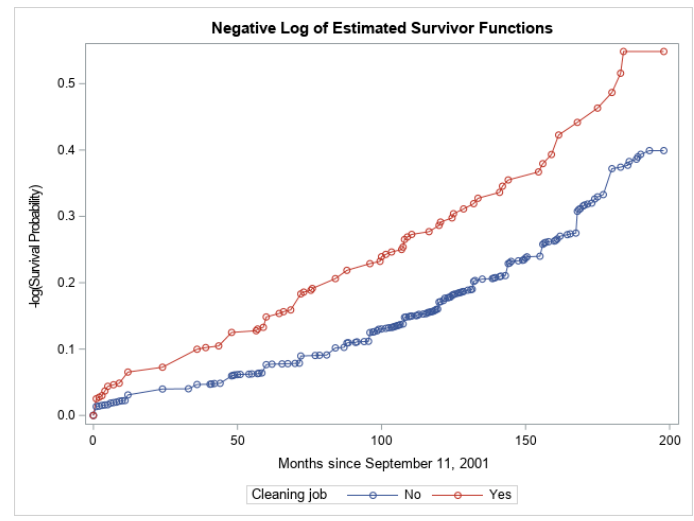
Figure 3. Nonparametric hazard functions of paresthesia-free survival stratified by cleaning job.